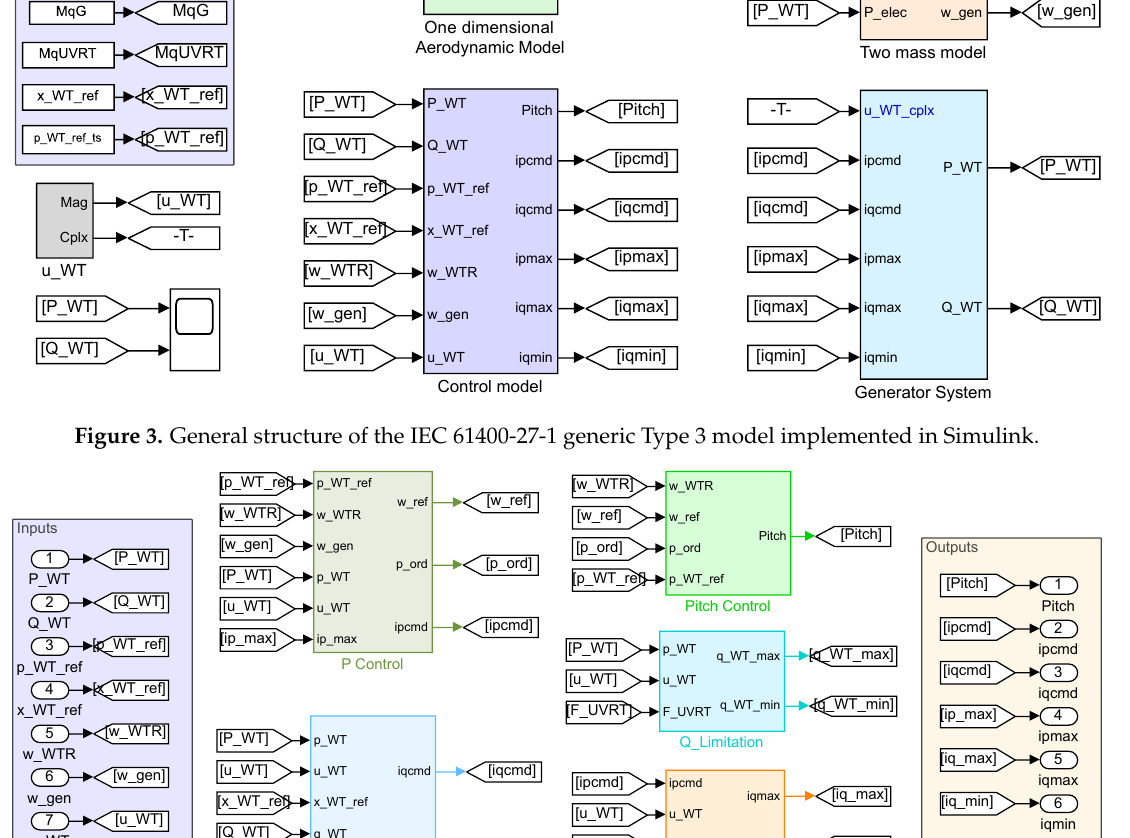
Figure 4. Control systems of the IEC 61400-27-1 generic Type 3 model implemented in